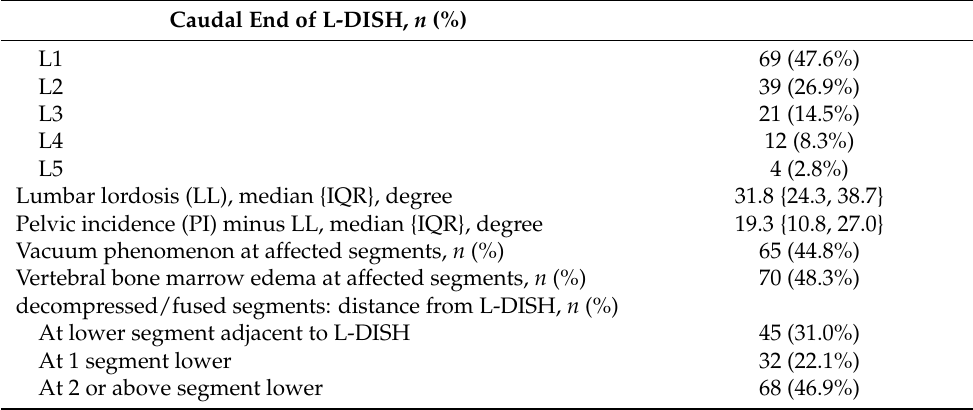
Table 2. Imaging findings of patients with L-DISH.